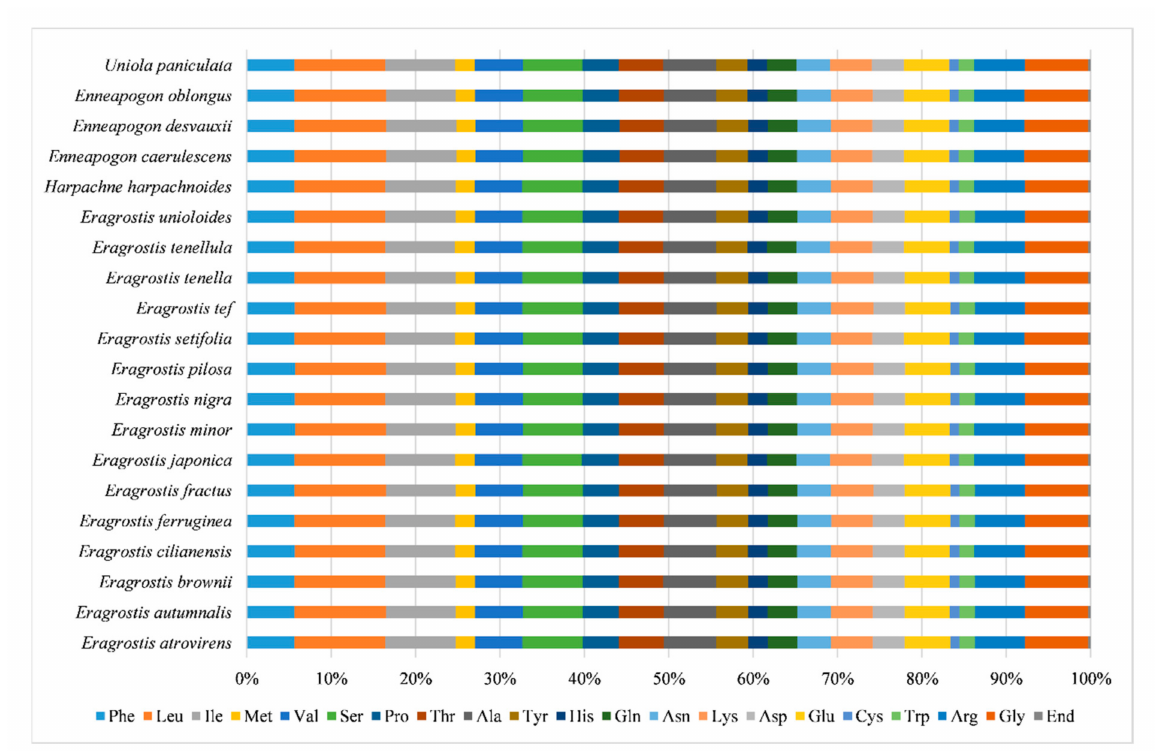
Figure 4. Amino acid proportion of protein-coding genes in 20 Eragrostideae chloroplast